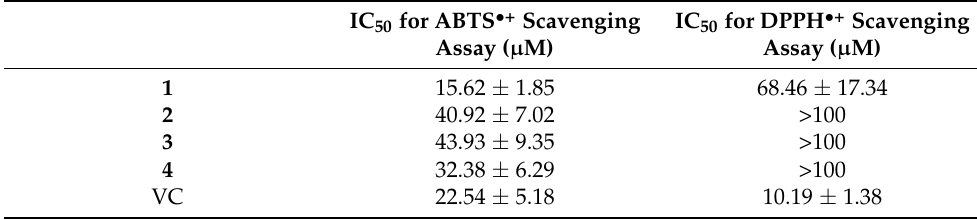
Table 2. ABTS • + and DPPH • + scavenging activities of compounds 1 – 4 a